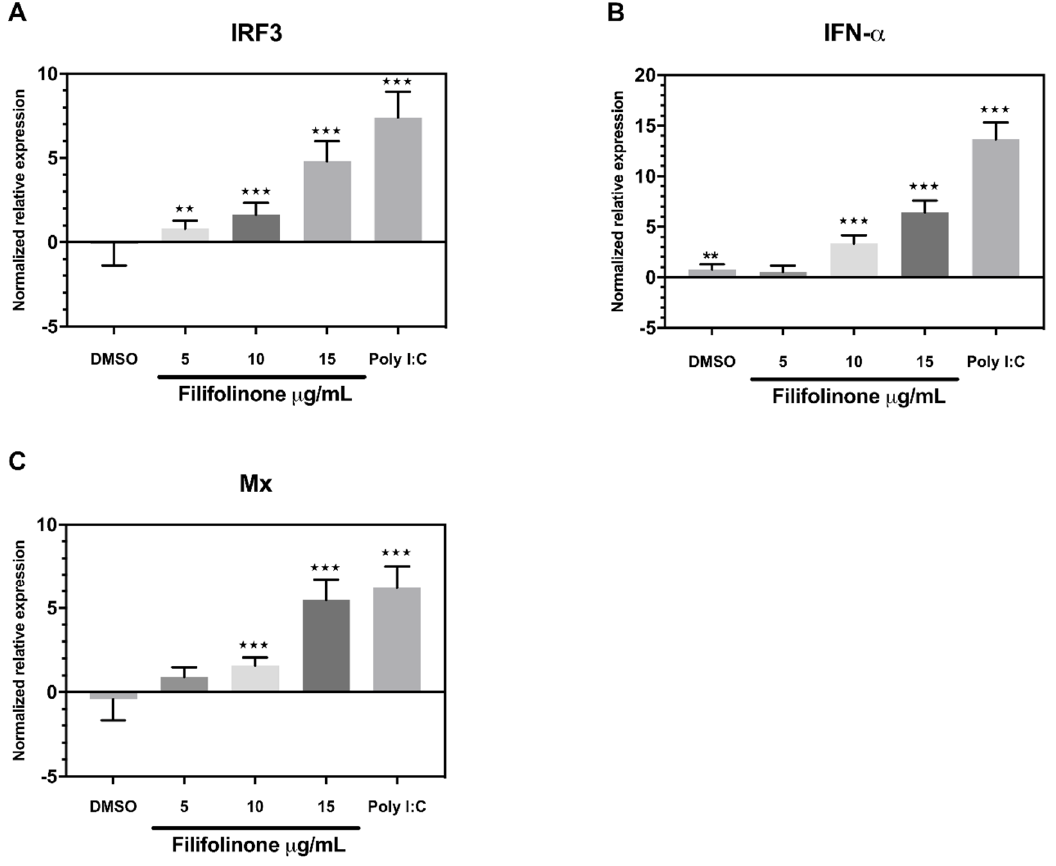
Figure 7. Transcript levels of innate immune response genes in primary culture of Atlantic salmon head kidney treated with filifolinone. The cells were incubated with 5, 10, and 15 μ g/mL of filifolinone for 24 h at 16 °C. The graphs show the transcript levels of transcription factor ( A ) IRF3; ( B ) cytokine IFN- α 1; and ( C ) protein Mx. The relative quantification of transcript levels was calculated using the Pfaffl formula. Normalization was carried out in relation to the untreated cultures and the constitutive expression gene ef1a (elongation factor 1 α ). Data are representative of three independent experiments. The statistical differences were determined between untreated and experimental cultures by the Mann–Whitney U test (** p < 0.01, *** p < 0.001).